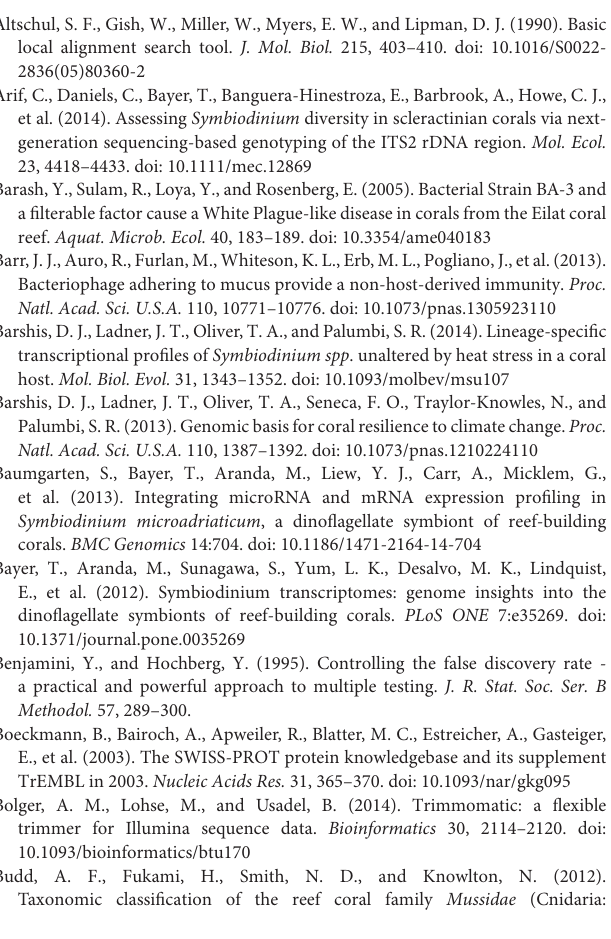
holobiont compartments. Supplementary Data 6 | merge_fastq.pl script.